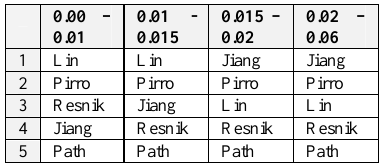
Table 2. Ranking of the similarity measures